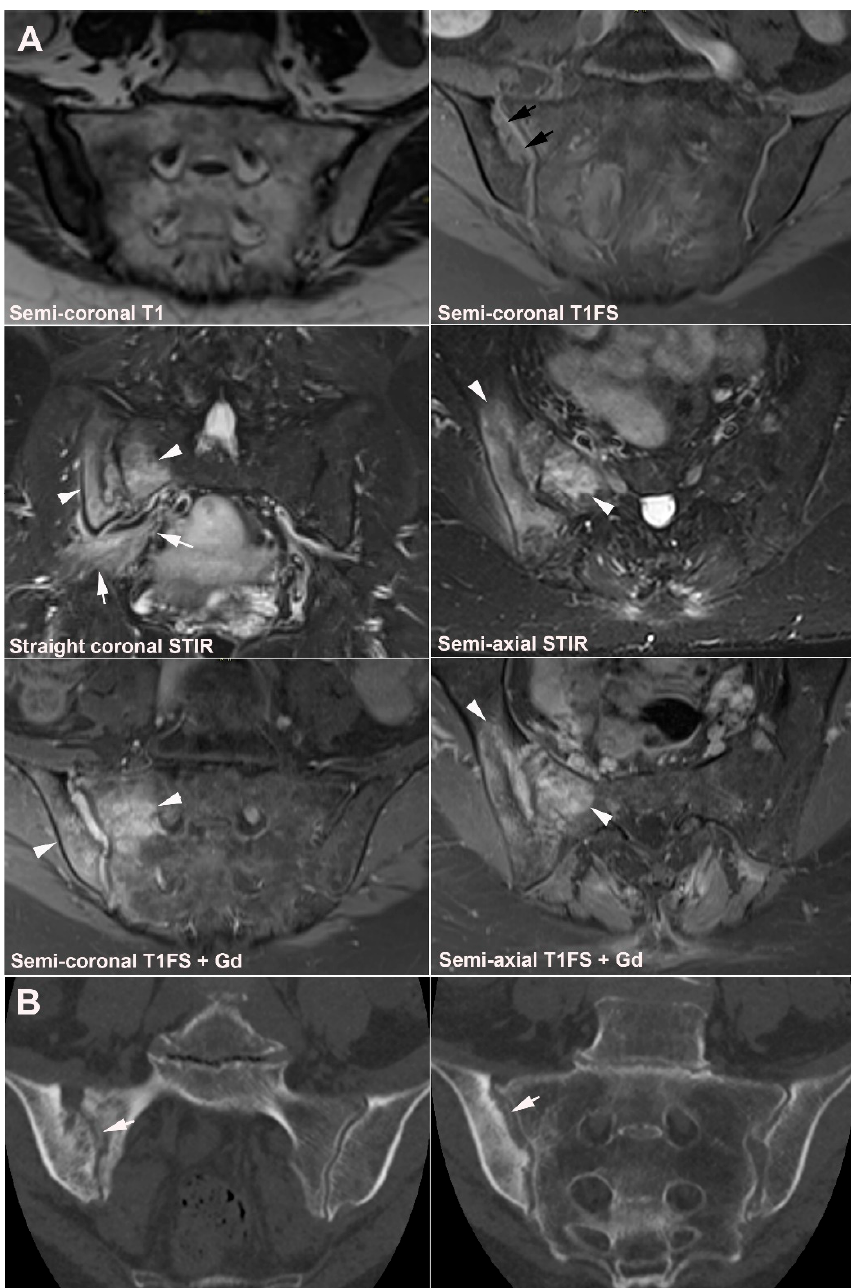
Figure 27. CPPD changes in a 72-year-old woman with inflammatory low back and buttock pain for three weeks, starting rather suddenly and with accompanying elevated CRP. ( A ) MRI, semi-coronal T1 and T1FS (upper image row), straight coronal and semi-axial STIR (middle row), and postcontrast semi-coronal and semi-axial T1FS showing pronounced edema and enhancement in the right joint space and the subchondral bone (arrowheads) with concomitant edema in the surrounding soft tissue, especially inferiorly to the joint (white arrows). Irregular iliac joint margins are seen with an iliac area lacking normal bone texture superiorly (black arrows on T1FS). ( B ) Supplementary CT and semi-coronal reconstructions revealed mineralization corresponding to the cartilage (arrows) indicating crystals in addition to an iliac area with subchondral bone resorption mimicking changes seen in hyperparathyroidism, which was not supported biochemically. It was revealed that the patient also had mineralization characteristic of CPPD in the spine and sternoclavicular joints (not shown).